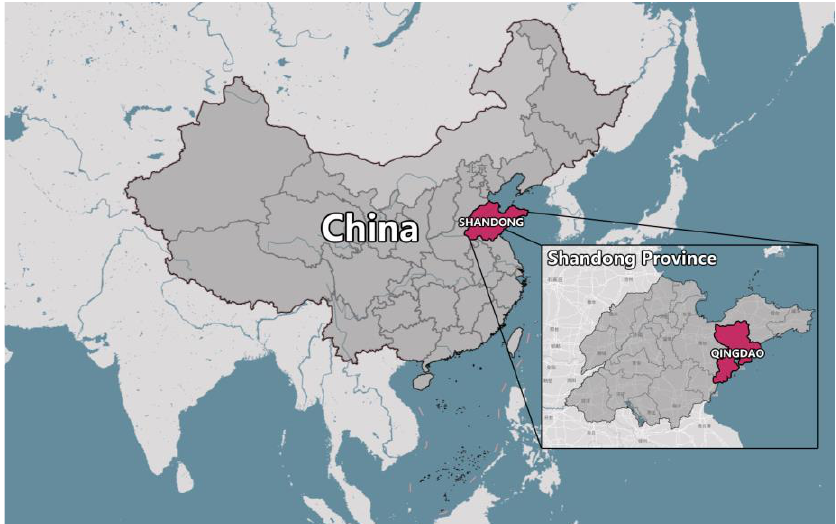
Figure 1. The map of Qingdao City, Shandong Province, People ’ s Republic of China.